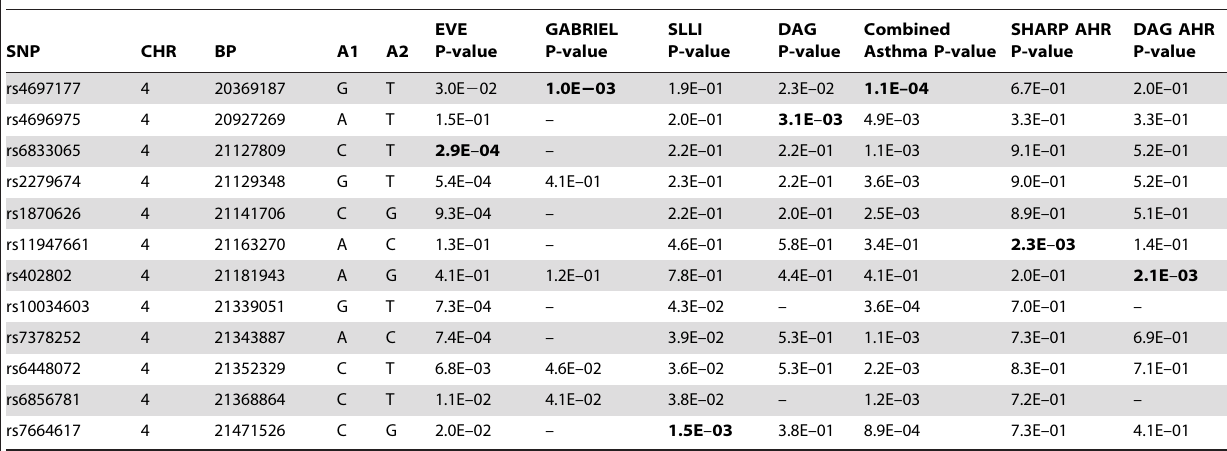
Table includes SNPs that have EVE P-value , 0.001, are the lowest in individual GWAS (indicated in bold), or have nominally significant (i.e. P-value , 0.05) replications in three of four asthma GWAS. P-values in asthma replication GWAS are 1-sided, based on the effect direction in EVE, to ensure that associations reported have effects